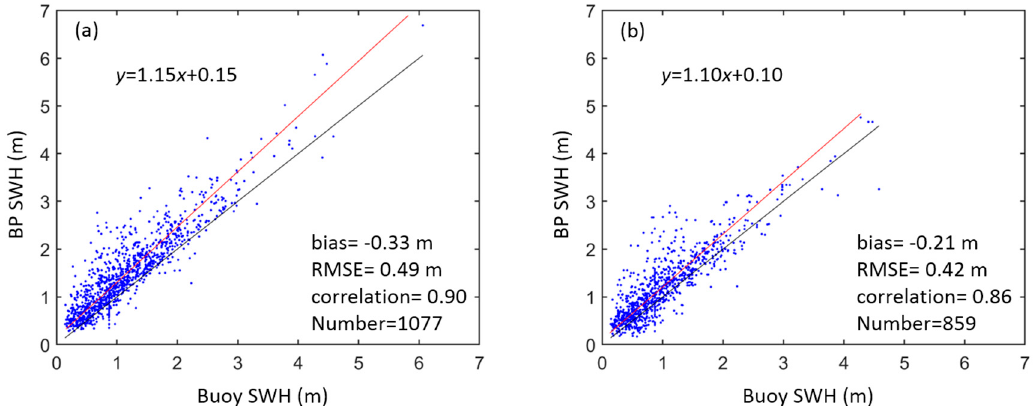
Figure 3. Scatter plots of pairs of 1 Hz BP and buoy SWHs according to the distance from the coast: ( a ) 12–50 km and ( b ) 0–12 km. The red line represents the linear relationship between these two datasets. The black line depicts the ideal situation that altimeter and buoy SWHs are the same with the unity slope.